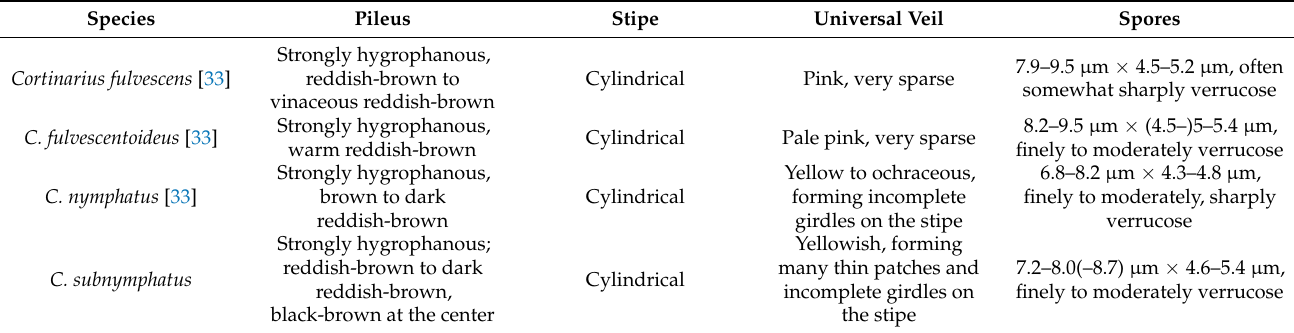
Table 4. Morphological comparisons of the new species and their similar species in sect. Laeti